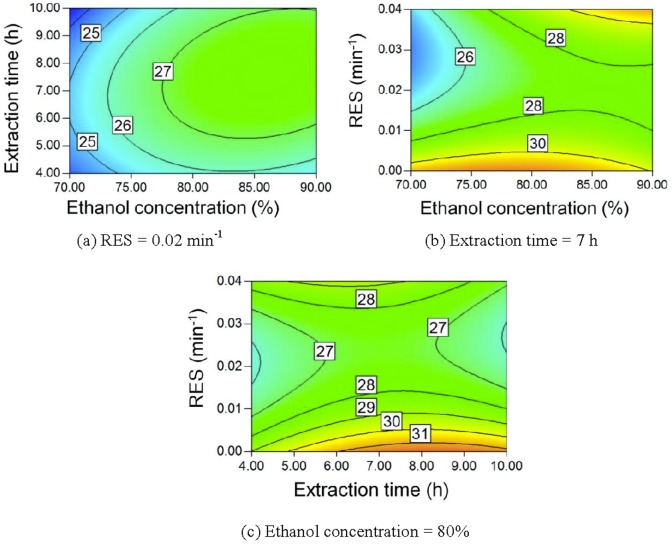
Contour plot of TSP.